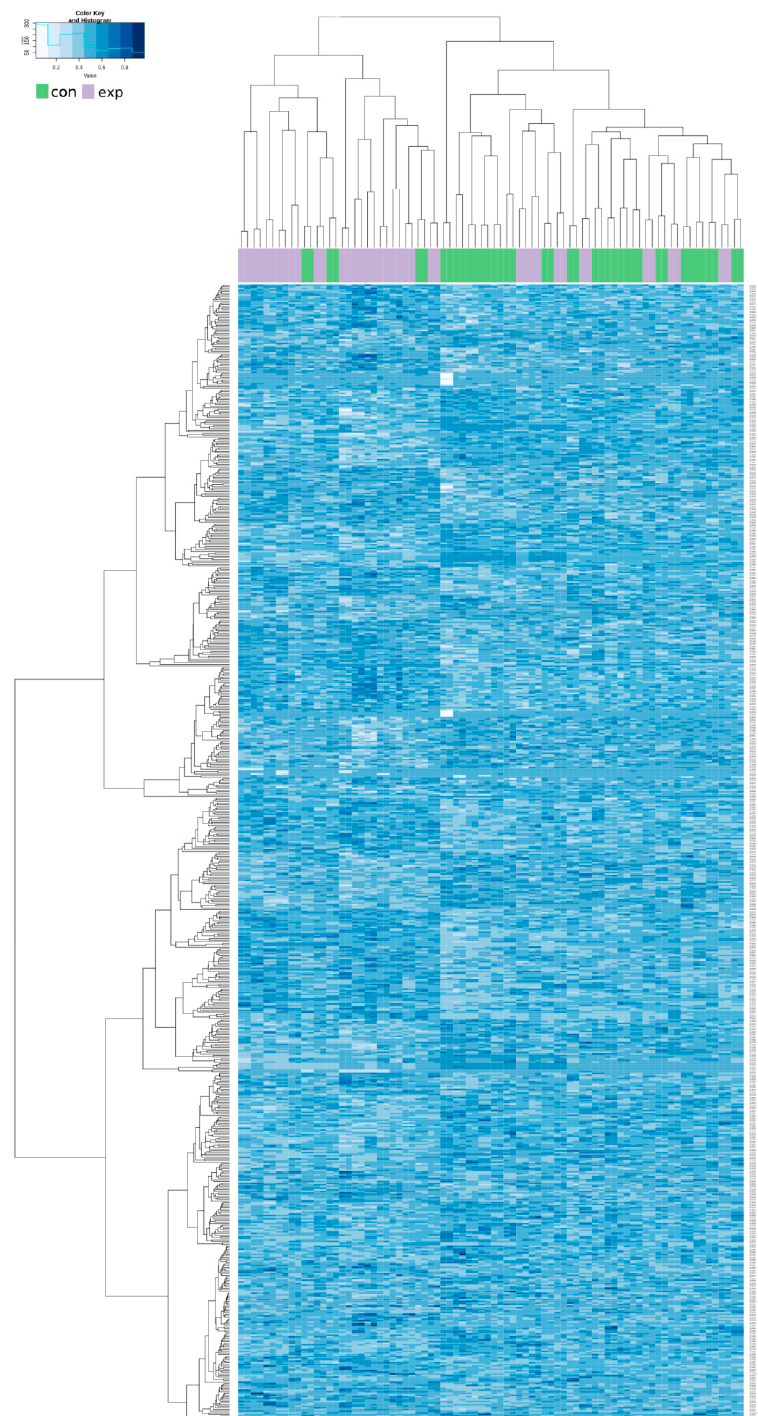
Figure A1. Hierarchical clustering analysis of all 705 differentially methylated CpG loci in exposed und control groups. Columns represent individual samples (exposed, purple; controls, green); methylation intensity in individual CpG sites are in rows.